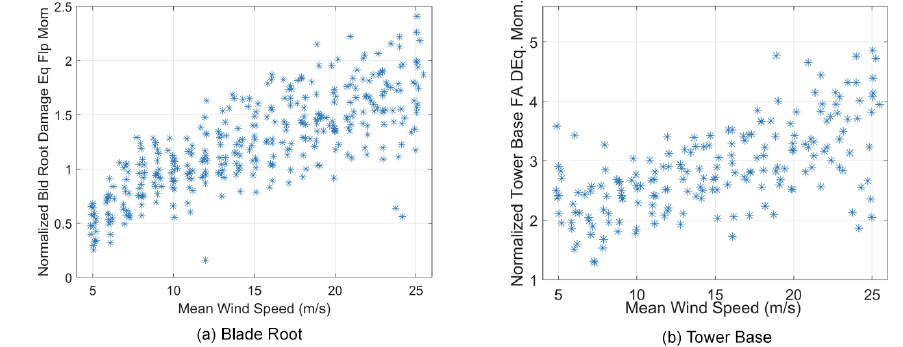
Figure 4. Simulated 10min (a) blade root flap damage equivalent moment and (b) tower base fore–aft damage equivalent moment, over different mean wind speeds and turbulence. The CoV of blade root flap DELs below rated wind speed is 0.31 and above rated wind speed is 0.22. The CoV of tower base FA DELs below rated wind speed is 0.31 and above rated wind speed is